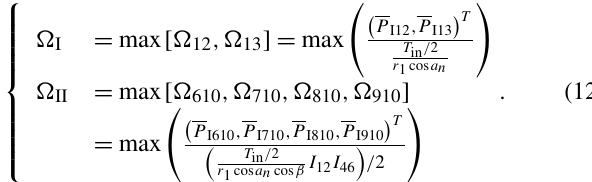
Table 2. Parameters of equivalent stiffness.